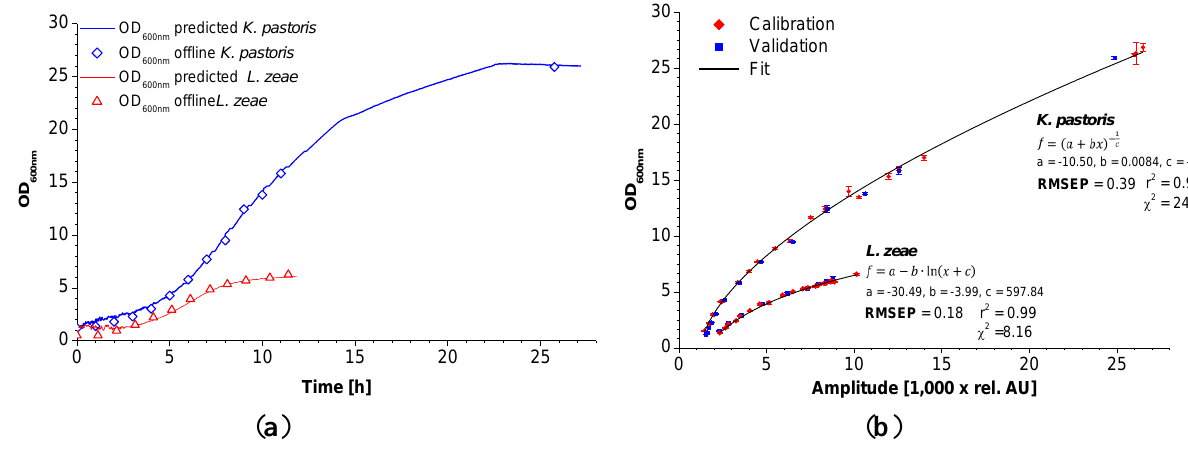
Figure 2. Exemplary dynamic calibration of the biomass sensor signal versus optical density at λ = 600 nm for K. pastoris and L. zeae ( a ). Red diamonds represent two experiments. Blue squares represent one validation experiment. Application of the calibration function on the biomass sensor signal of the validation growth curve along with the offline measured data ( b ).